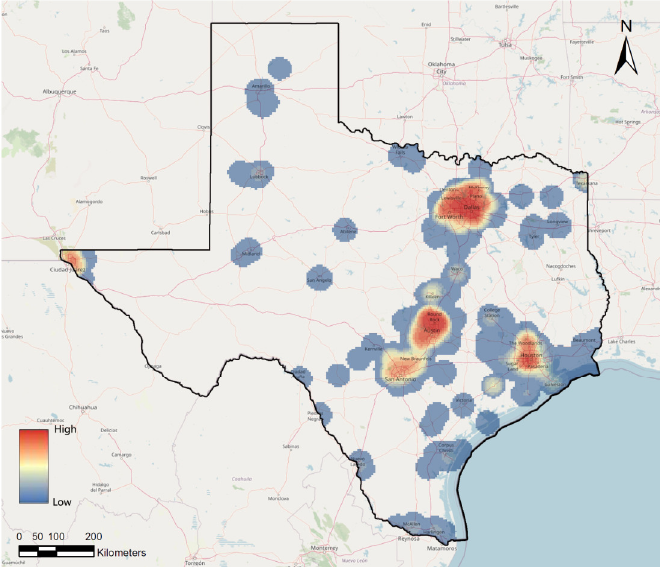
Figure 5. Spatial distribution density of green buildings in Texas.